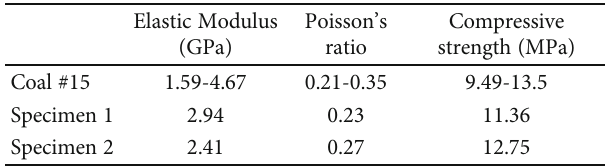
Figure 1: Macroscopic fracture development characteristics of Qinshui Basin [24, 25]: (a) rose diagram of the macroscopic fracture spreading orientation of the Qinshui Basin stratigraphy; (b) 1 — macroscopic fracture map of coal seam #15 in Si-he coal mine; 2 — macroscopic fracture map of coal seam #15 in Cheng-zhuang coal mine. Table 1: Mechanical parameters of similar material test blocks and coal